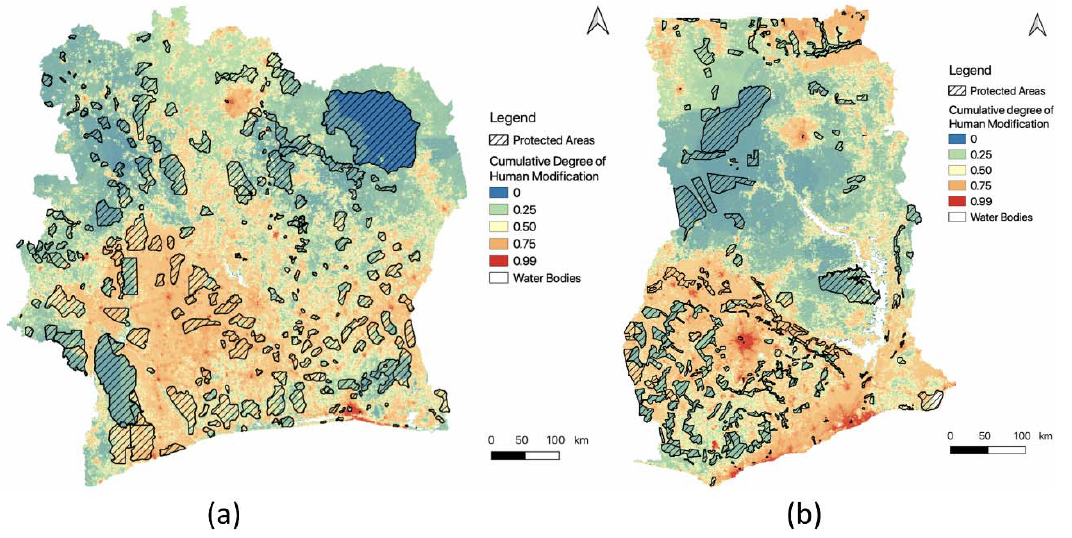
Figure 4. Protected areas and cumulative degree of human modification in ( a ) Côte d’Ivoire and ( b ) Ghana, West Africa. Table 8. Summary statistics (median, mean, and CI for mean value) for the cumulative degree of human modification estimated in protected areas in Côte d’Ivoire and Ghana’s (IUCN PA categories, those without assigned categorizations (not reported) and World Heritage Sites or UNESCO MAB reserves (not applicable)).